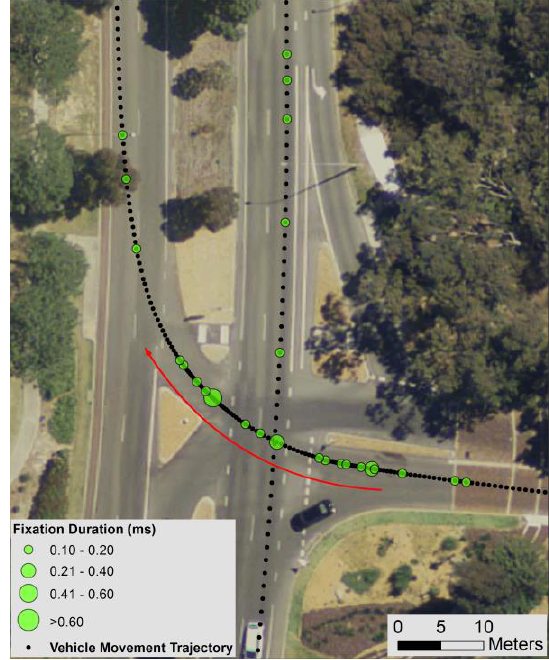
Figure 2. The spatial distribution of eye fixation behaviour at roundabout U-turn from driver A